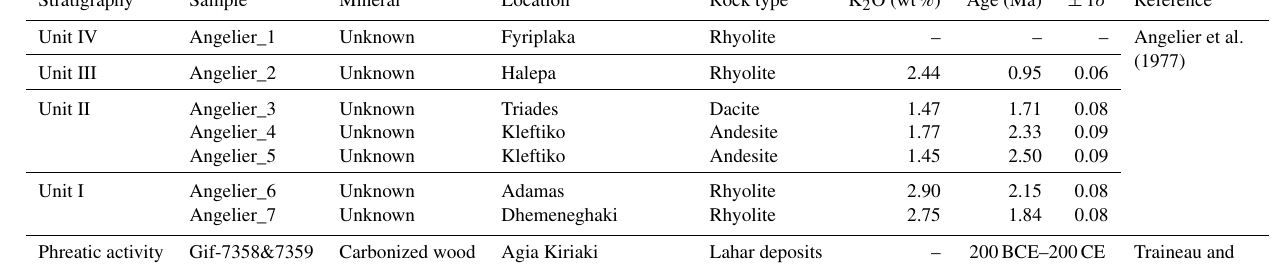
Table 1. Published eruption ages of stratigraphic units of the island of Milos.